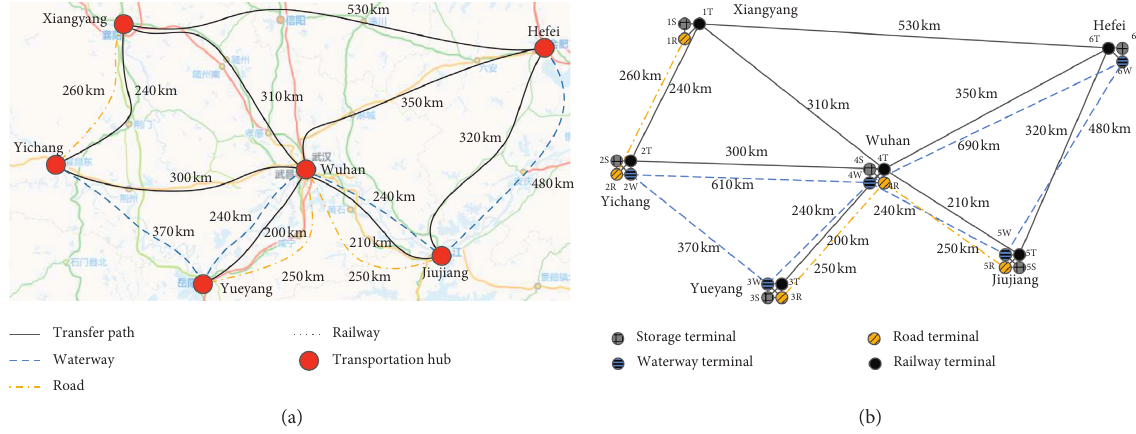
Figure 6: The intermodal transport network in the middle section of the Yangtze River Basin.